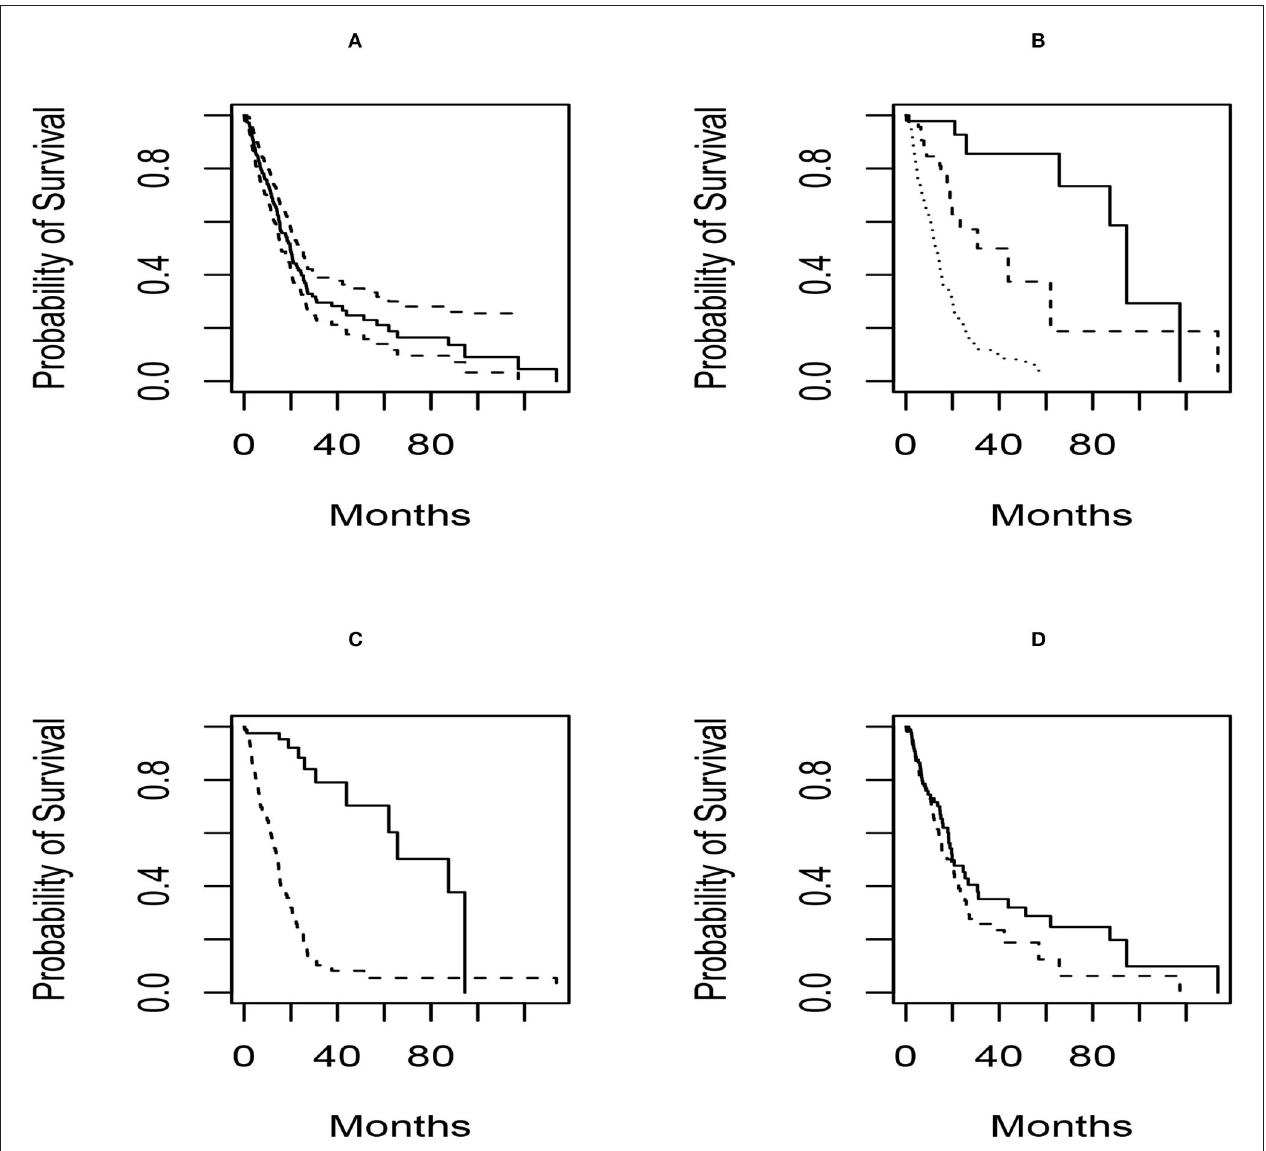
FIGURE 2 | Survival distribution plots for the subjects in the glioblastoma radiomics study. For all plots, the x axis represents the time in weeks and the y-axis is the survival probability. Panel (A) shows the Kaplan–Meier plot for the entire population, along with associated 95% pointwise confidence intervals. Panel (B) shows the Kaplan–Meier estimates by grade (solid = grade 2; dashed = grade 3; dotted = grade 4). In Panel (C) , the survival distributions by IDH mutation status (solid = mutant; dashed = wild-type) are presented. Finally, the gender-specific survival distributions (solid = female; dashed = male) are given in (D)